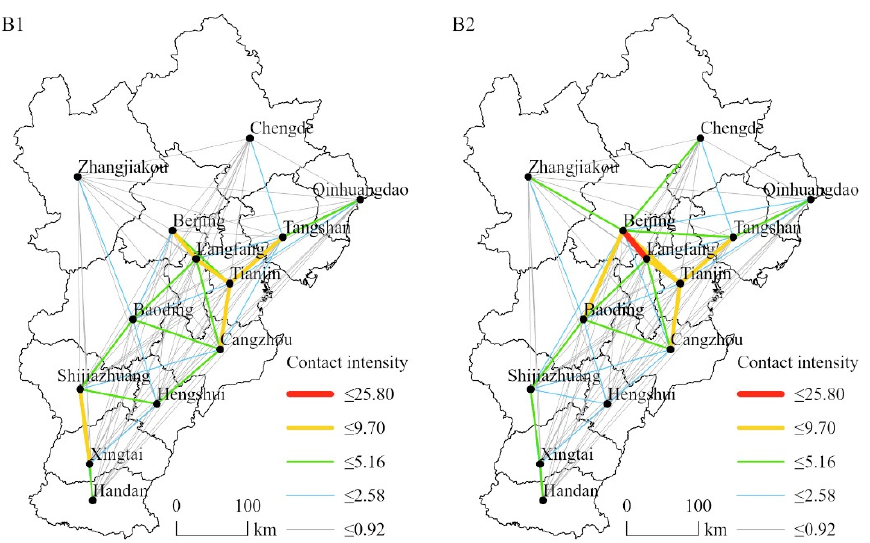
Figure 3. Comparison of population mobility network patterns in B1 and B2.